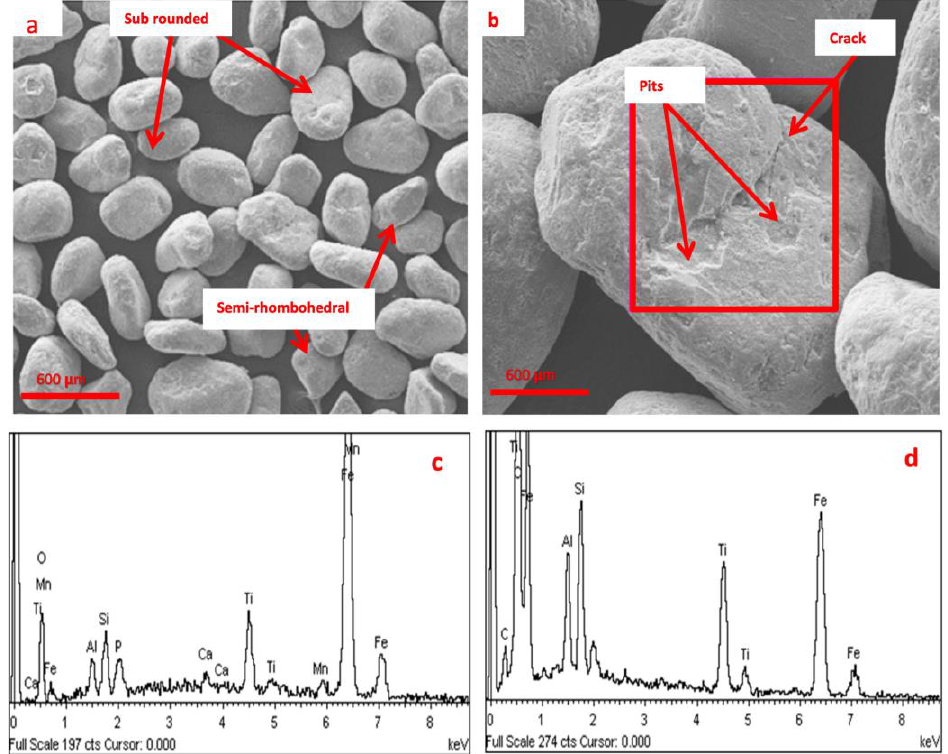
Figure 2. SEM micrograph of ilmenite with particles sizes of ( a ) +75 µ m and ( b ) +106 µ m and EDS analysis of sizes ( c ) +75 µ m and ( d ) +106 µ m. Table 3. Elemental analysis of the ilmenite ore by ICP-OES